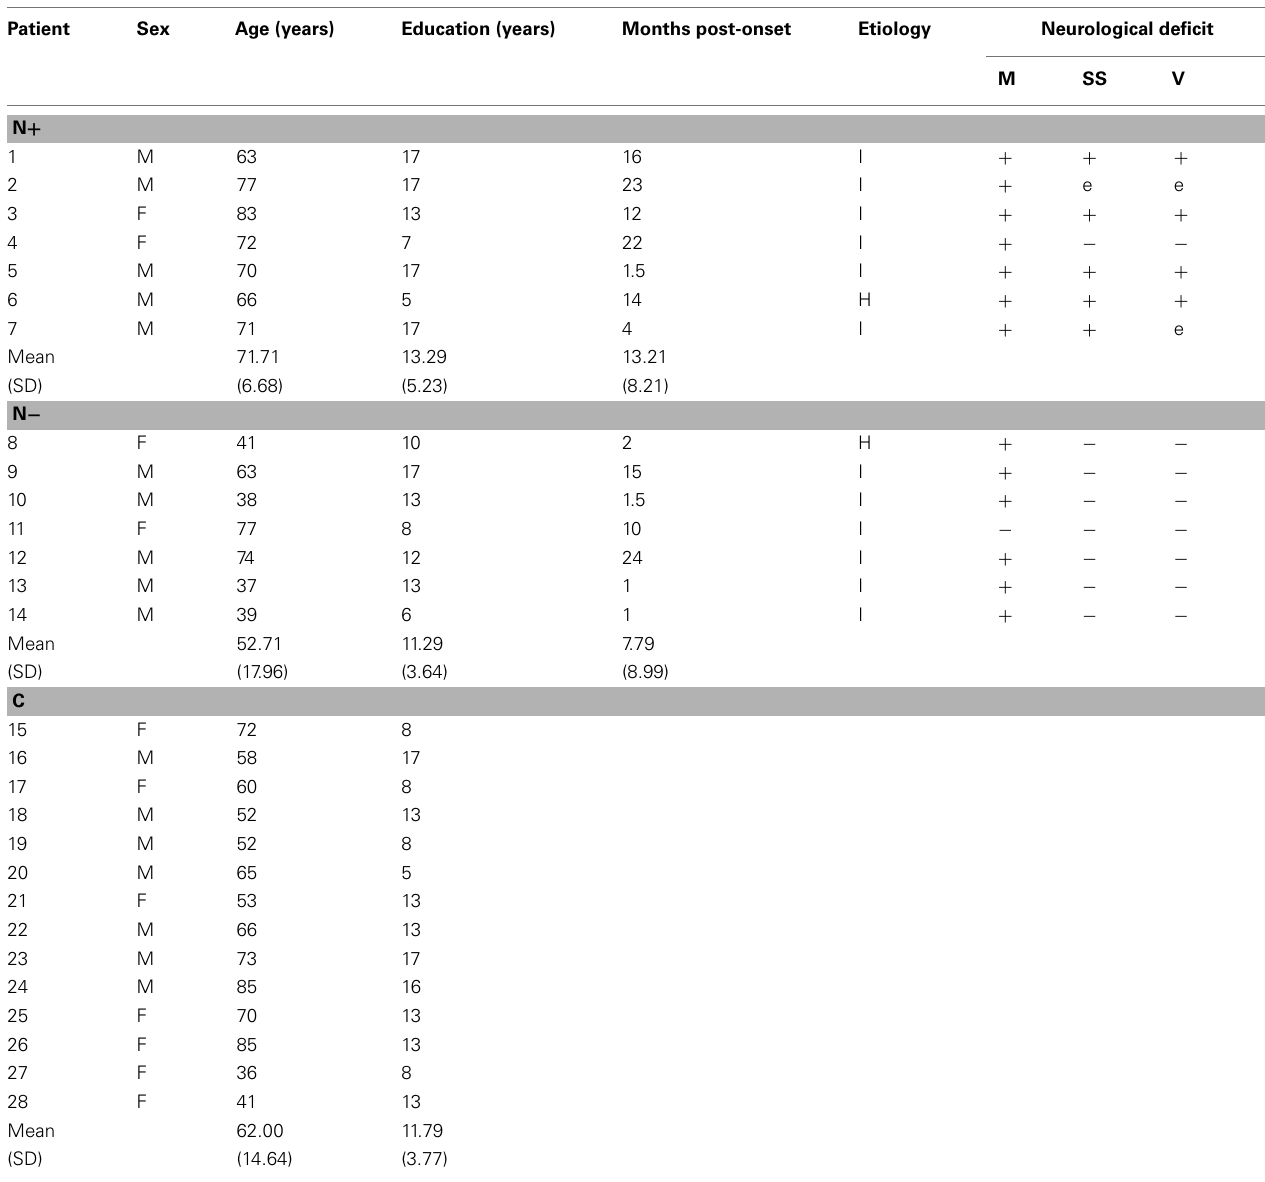
Table 1 | Demographical and neurological data of 14 right-brain-damaged patients with (N + ) and without (N − ) USN, and of 14 control (C) neurologically unimpaired